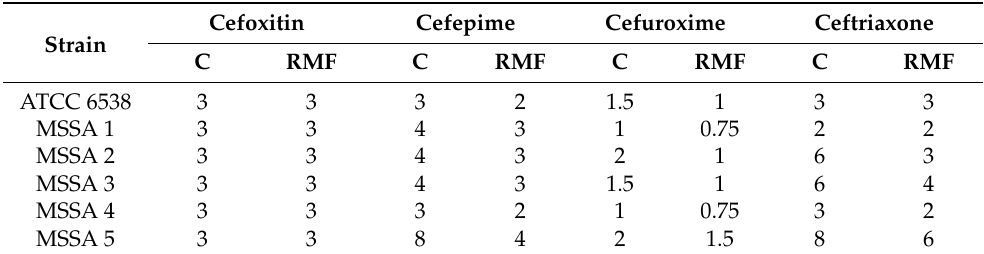
Table 6. MIC values ( µ g/mL) for β -lactam antibiotics in control and RMF-exposed (5 Hz) MSSA